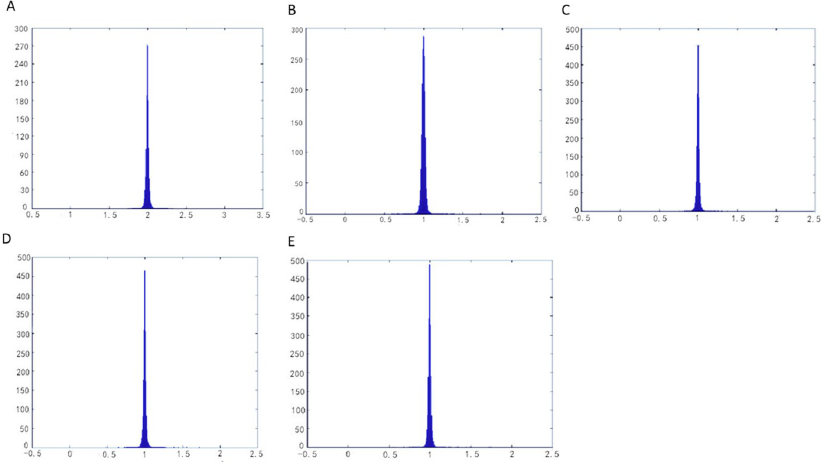
Fig 12. Histograms of angle distortions on the balls model. (A) result by LABF,(B) result by LQHP,(C result by IQCP,(D) result by QCTM,(eE) result by our method.